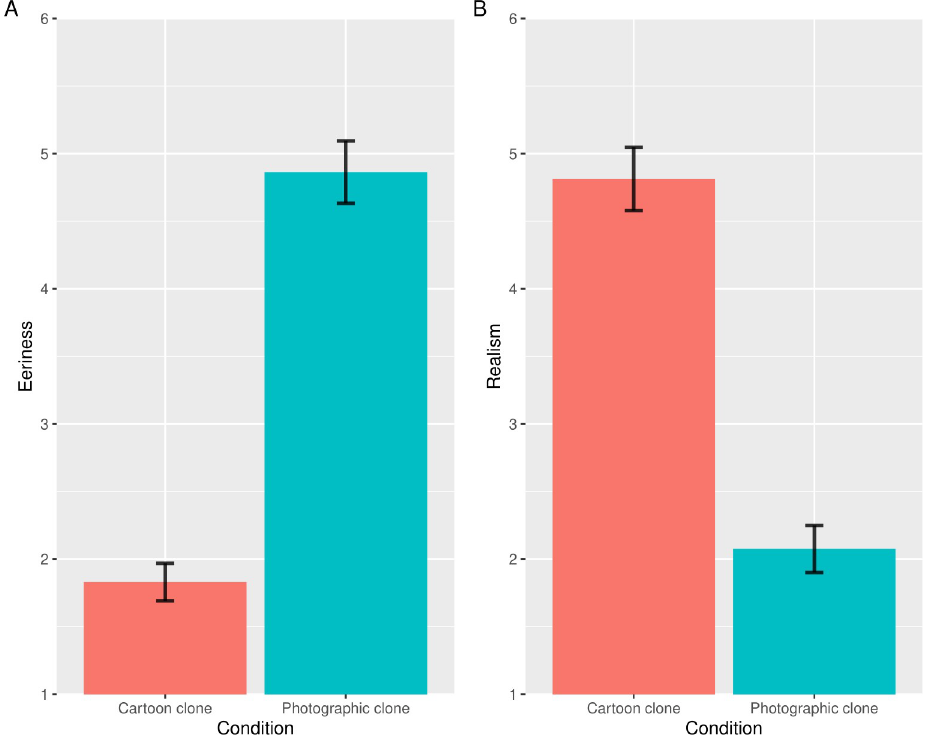
Fig 7. The results of the eeriness and realism evaluation in Study 5. Error bars indicate the standard errors of the mean. The vertical axes indicate the mean eeriness (A), with realism scores (B) for images in each condition. The lower scores in realism indicate more improbable